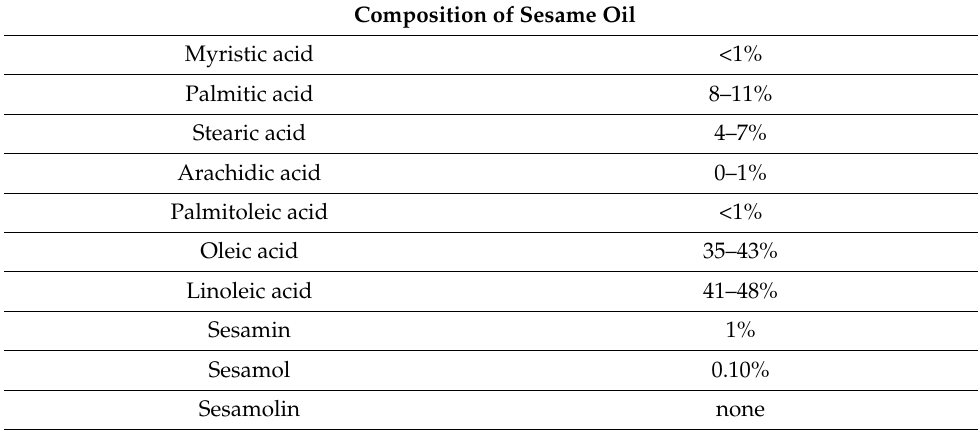
Table 2. Lipid profile of sesame oil presented in the format required by the Japanese pharmacopoeia. Less than 1% of the fatty acids are in free form. Rest are bound as acyl chains in triglycerides: 8% GS2U, 41% GSU2, and 51% GU3 respectively (here: G—glyceride backbone, U—unsaturated and S—saturated acyl chain